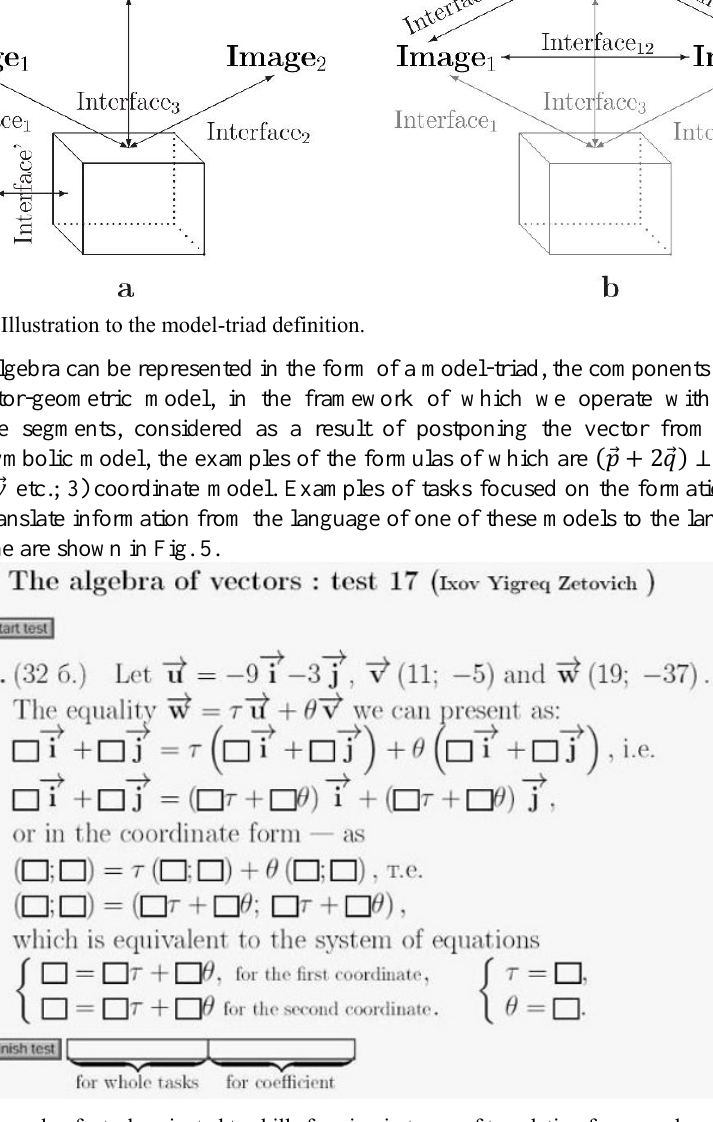
Fig. 5. An example of a task, oriented to skills forming in terms of translating from one language model to the other language model in the algebra of